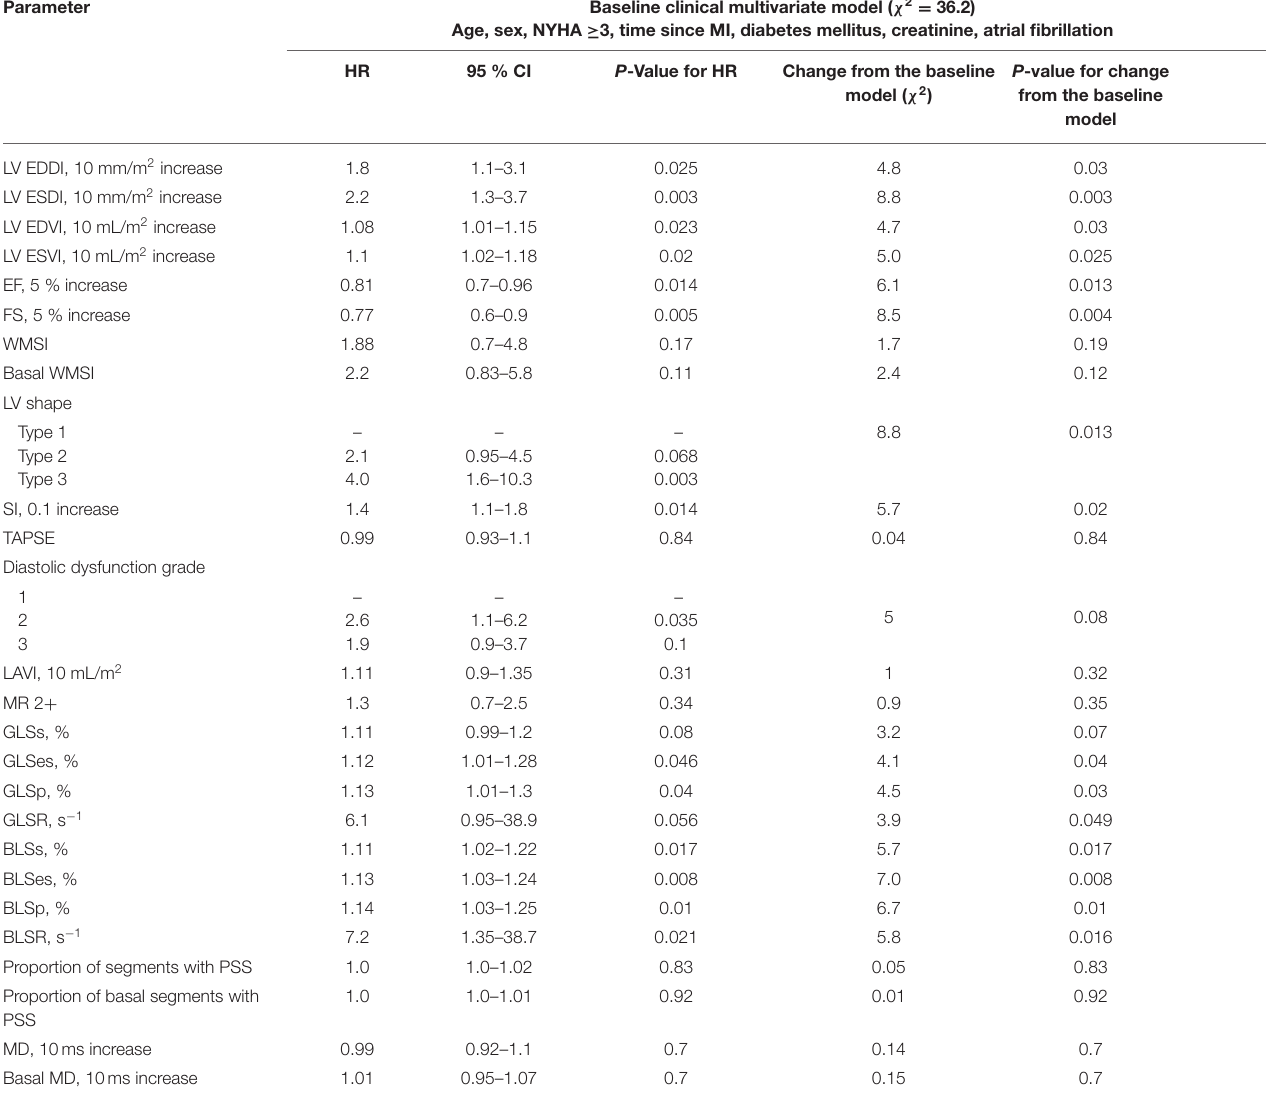
TABLE 3 | The multivariate analysis of preoperative echocardiographic parameters for predicting the combined outcome.